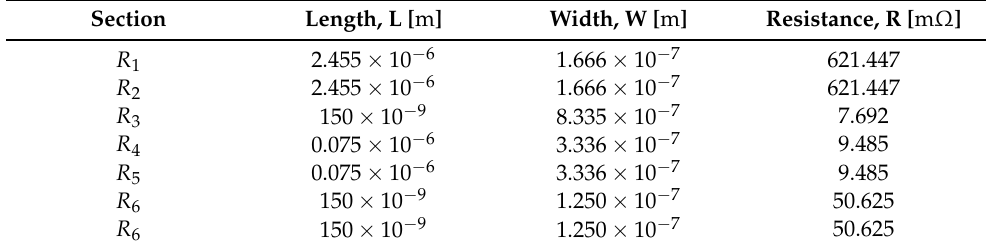
Table 6. Aluminum sections dimensions and resistance value.